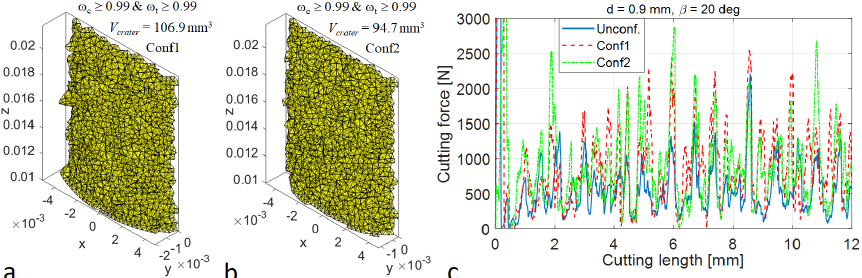
Figure 9. Simulation results for PDC cutting ( d = 0.9 mm, β = 20 ◦ , w c = 0.15): ( a ) removed elements in Conf1; ( b ) removed elements in Conf2; ( c ) cutting force vs. cutting length curves.